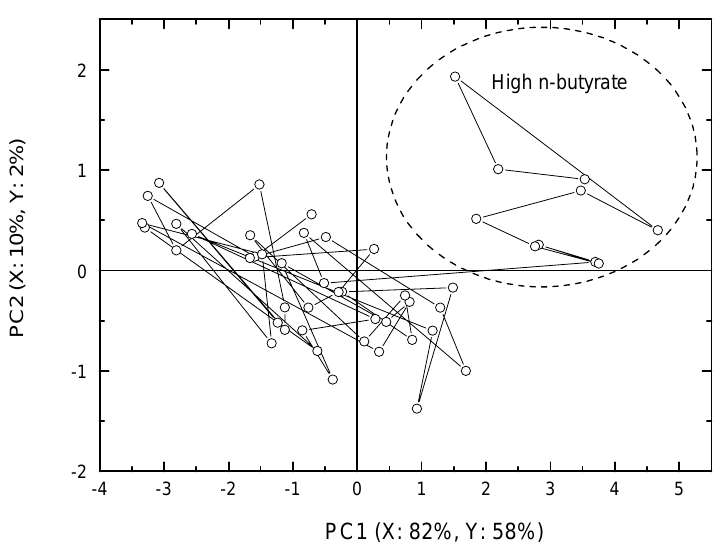
Figure 7. PLS-1 score plot of all samples in test mixtures of key odorants containing p-cresolate at pH 6. Samples (10 samples) with high concentrations (5 × 10 -4 - 10 -3 M) of n-butyrate are surrounded by dashed line. Full cross validation was used and five electrodes were